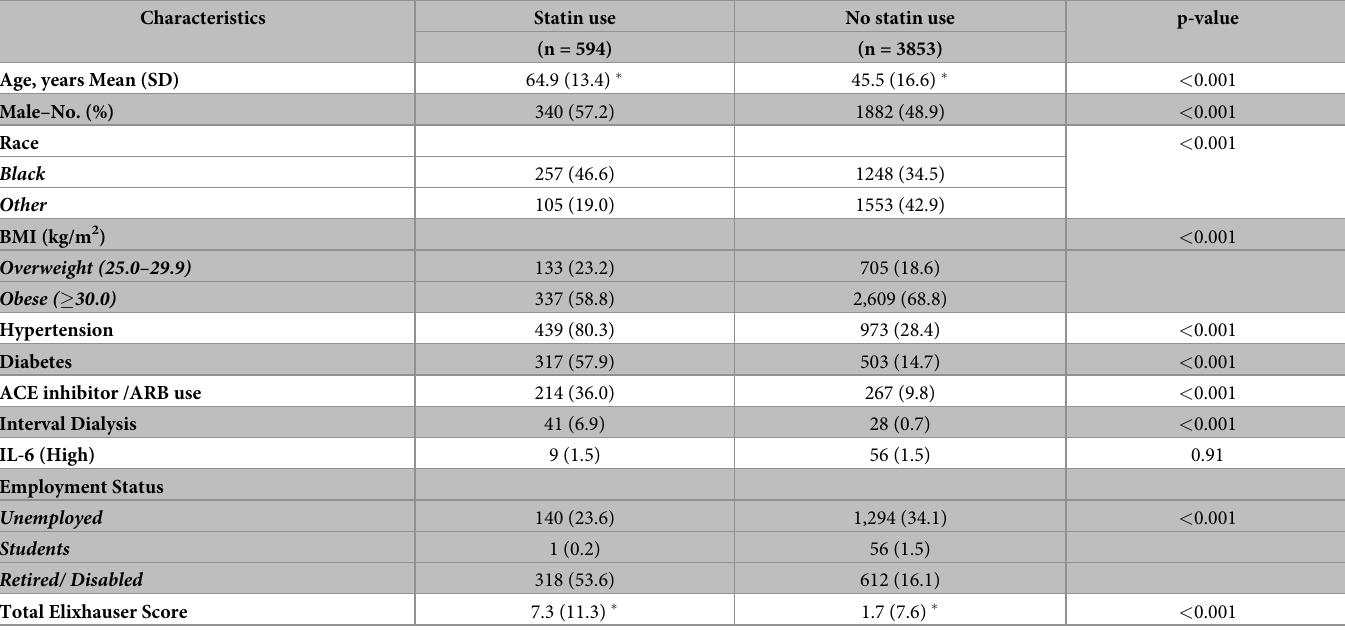
Table 1. Baseline characteristics of statin users versus statin non-users.